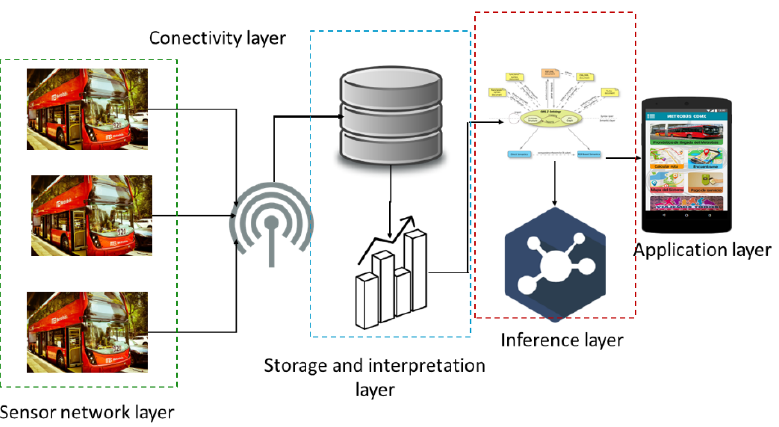
Figure 2. Proposed architecture of the developed model.